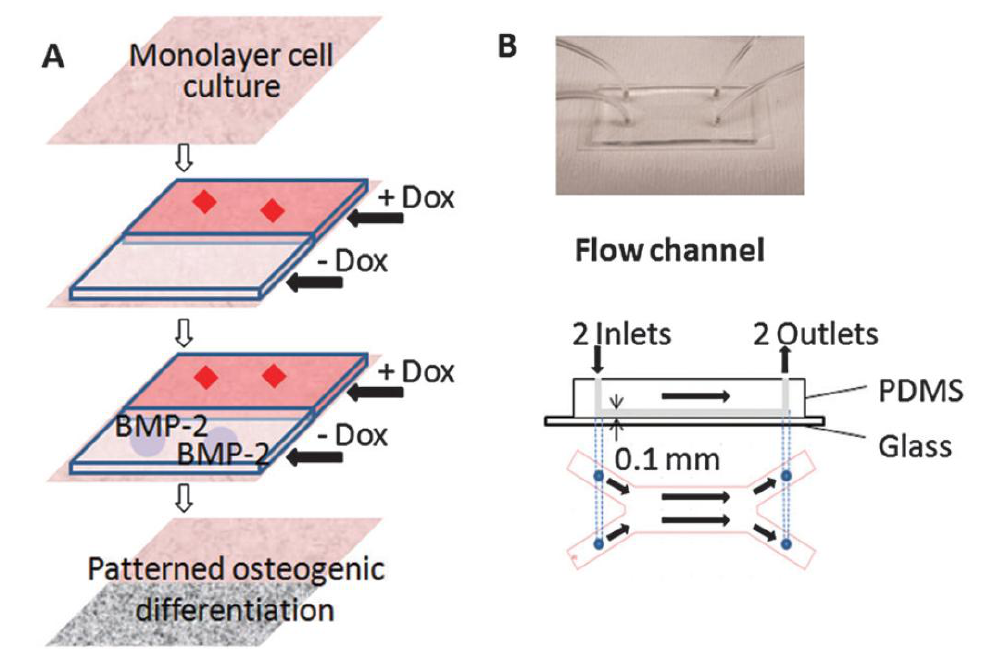
Figure 4. Patterning osteogenic cell differentiation using two layers of microflows. ( A ) Cultured cells were exposed to laminar flow with two streams, with and without Dox, a bone morphogenetic protein-2 (BMP-2) inhibitor. The patterned Dox layers led to patterned BMP-2 expression, thereby leading to patterned osteogenic differentiation. ( B ) Image and schematic of the flow channel. Reprinted with permission from the Royal Society of Chemistry (Zhang et al.